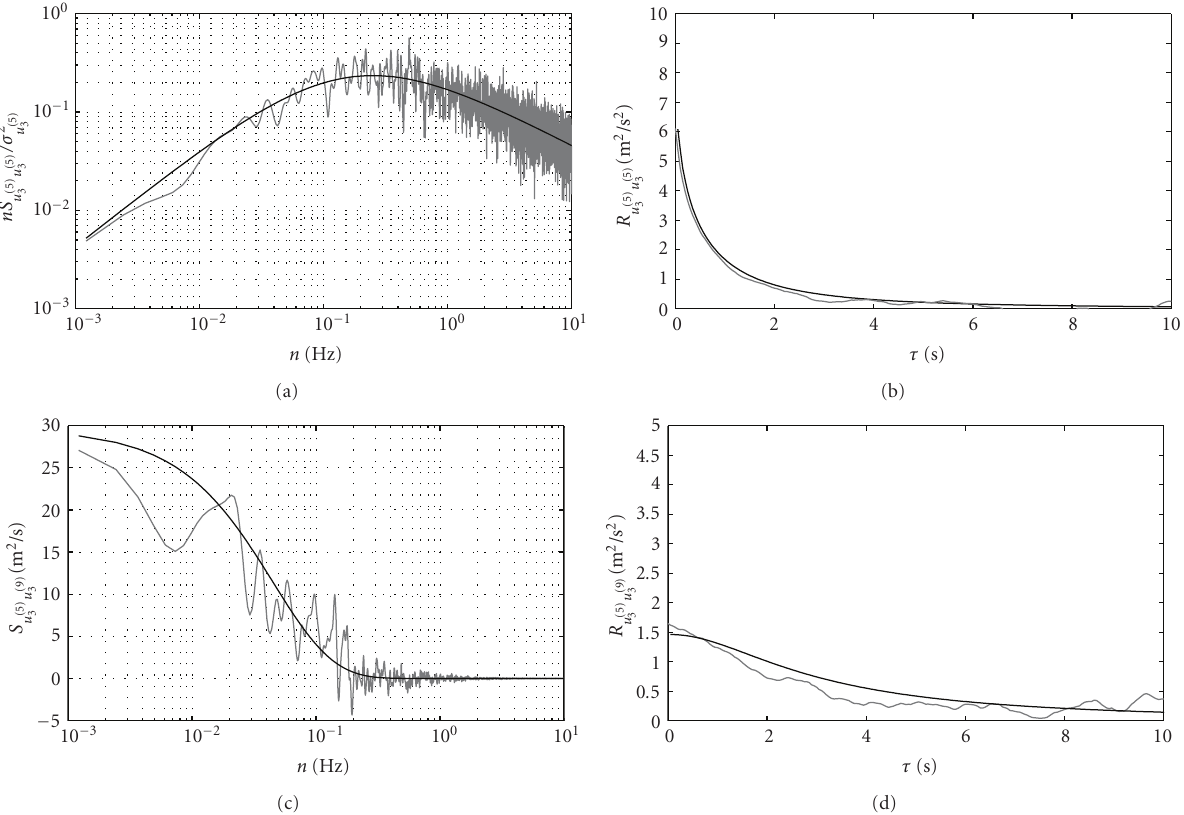
Figure 8: Example 1 using POD method (black lines denote target functions, gray lines denote numeric approximations): autospectrum of across-wind velocity at point 5 (a); corresponding autocorrelation function (b); cross-spectrum between across-wind velocities at points 5 and 9 (c); corresponding cross-correlation function